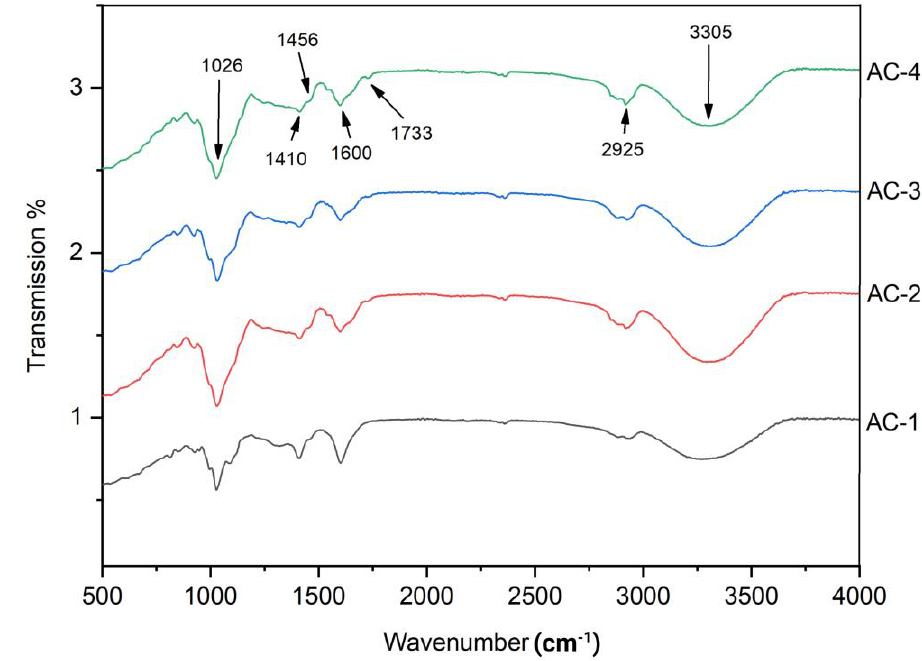
Figure 4. FTIR spectrum of SA–AG hydrogel-based edible films; AC-1/Control, AC-2 contains 15 µ L of CEO, AC-3 contains 20 µ L of CEO and AC-4 contains 30 µ L of CEO.